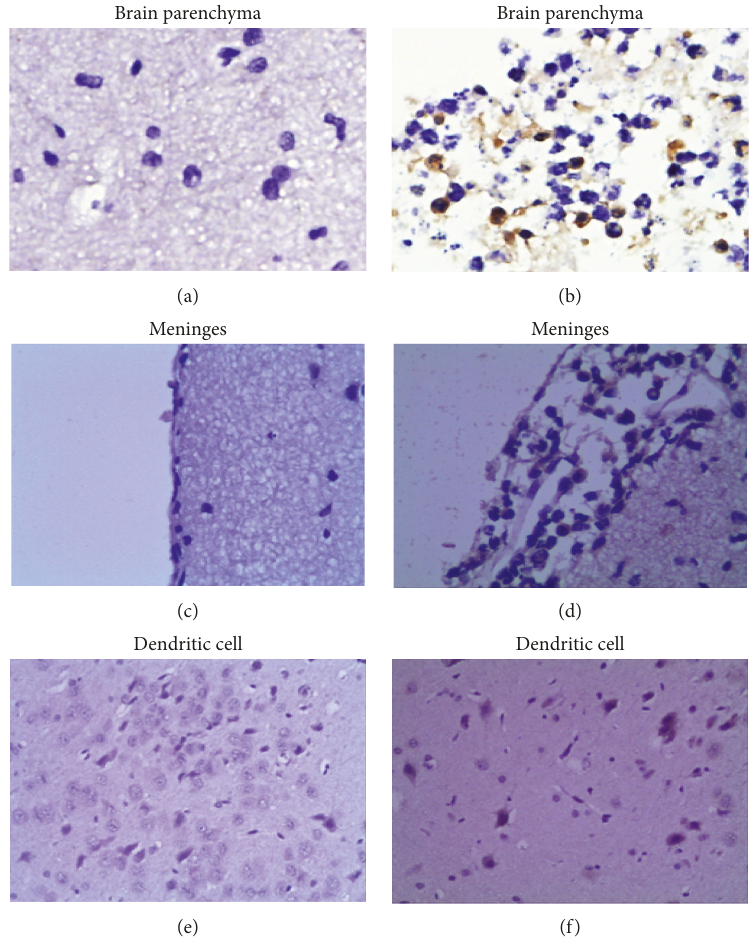
Figure 4: Changes in NOD2 protein expression in brain tissues of rats (IHC, observed in normal brain tissue. (b, d, f) NOD2 immunopositive cells were widely expressed in the infected Wistar rat meninges, brain parenchyma, and dendritic cells.